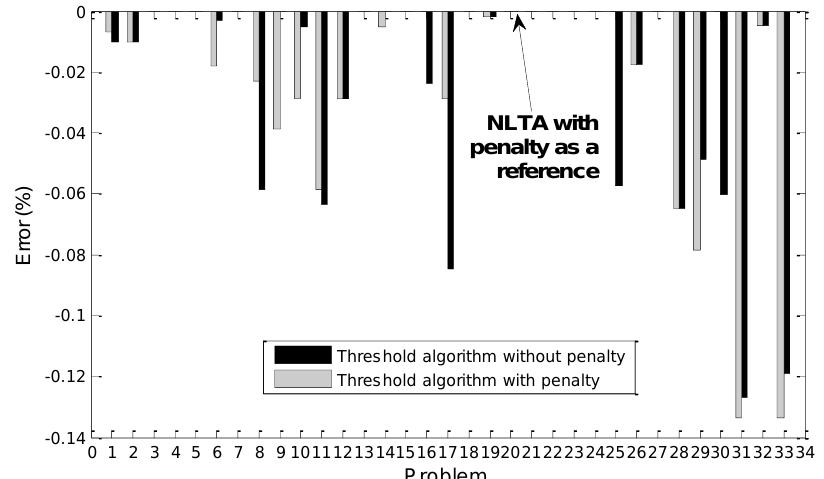
NLTA with penalty as a